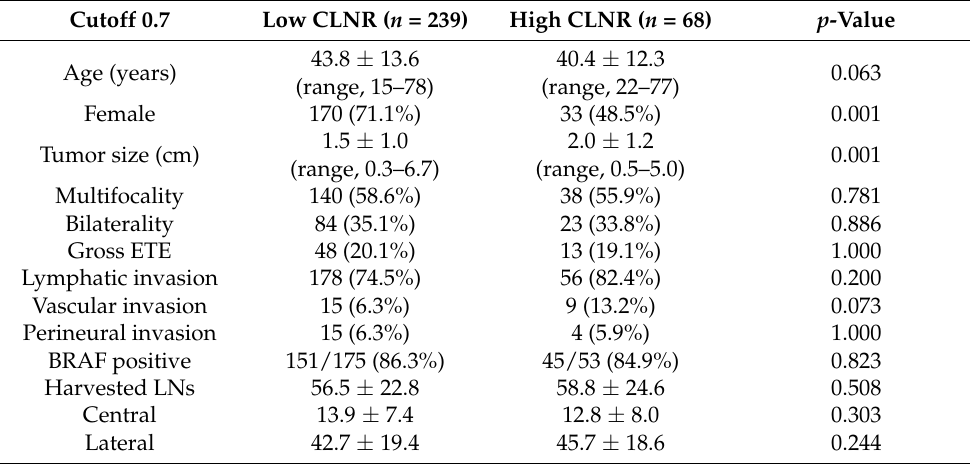
Table 2. Comparison of baseline clinicopathological characteristics according to